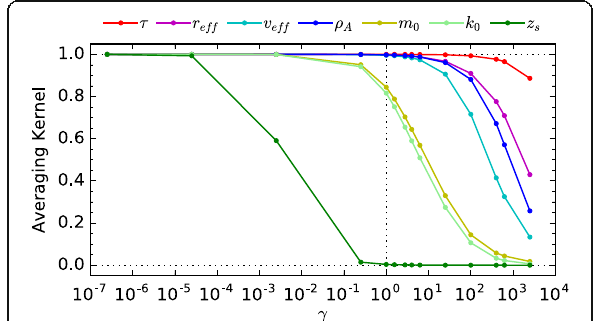
Fig. 6 Relation between regularization parameter ( γ ) of dust model parameters and diagonal elements of AKM. This graph shows an increased importance of a priori parameters for increasing γ . An SZA of 60° has been assumed for this